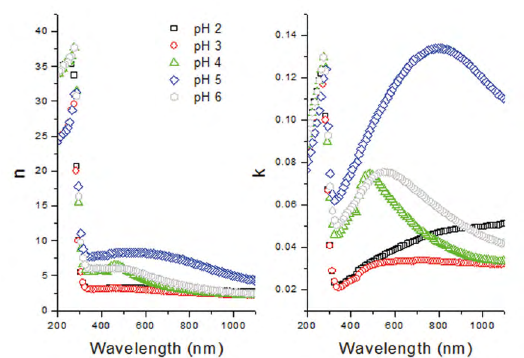
Figure 9. Dielectric coefficients (ε) of AgI thin films grown at different pH